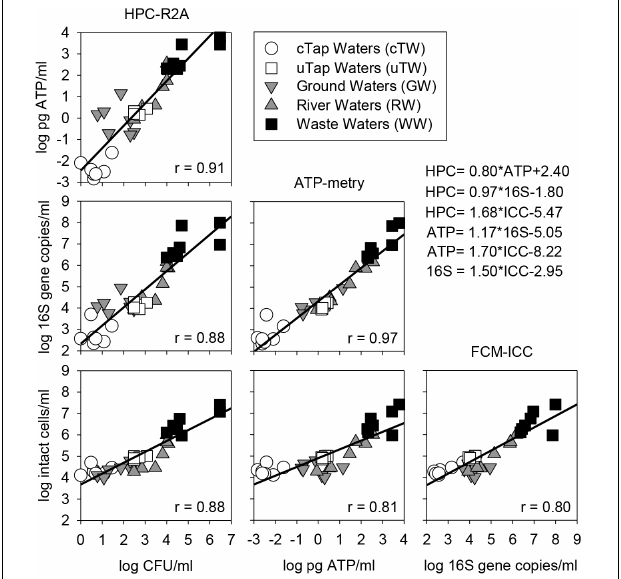
FIGURE 3 | Correlation matrix (log-log) among alternative parameters to assess microbial contamination in waters of different origin (i.e., cTW and uTW, chlorinated and unchlorinated tap waters; GW, ground waters; RW, river waters; WW, waste waters). Equations of Linear Regression Models (LRMs) are reported, along with Sperman’s correlation coefficients